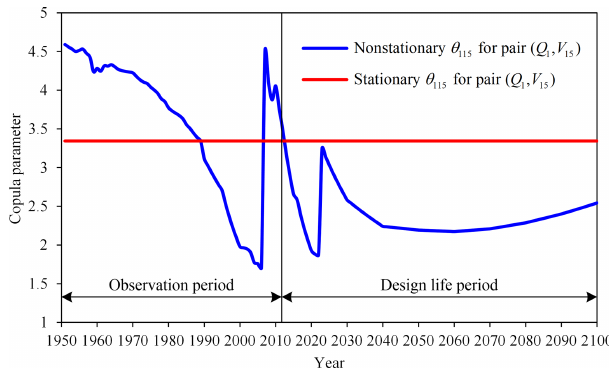
Figure 6. Nonstationary copula parameter for pair (Q 1 , V 15 ) dur- ing both the observation and design life